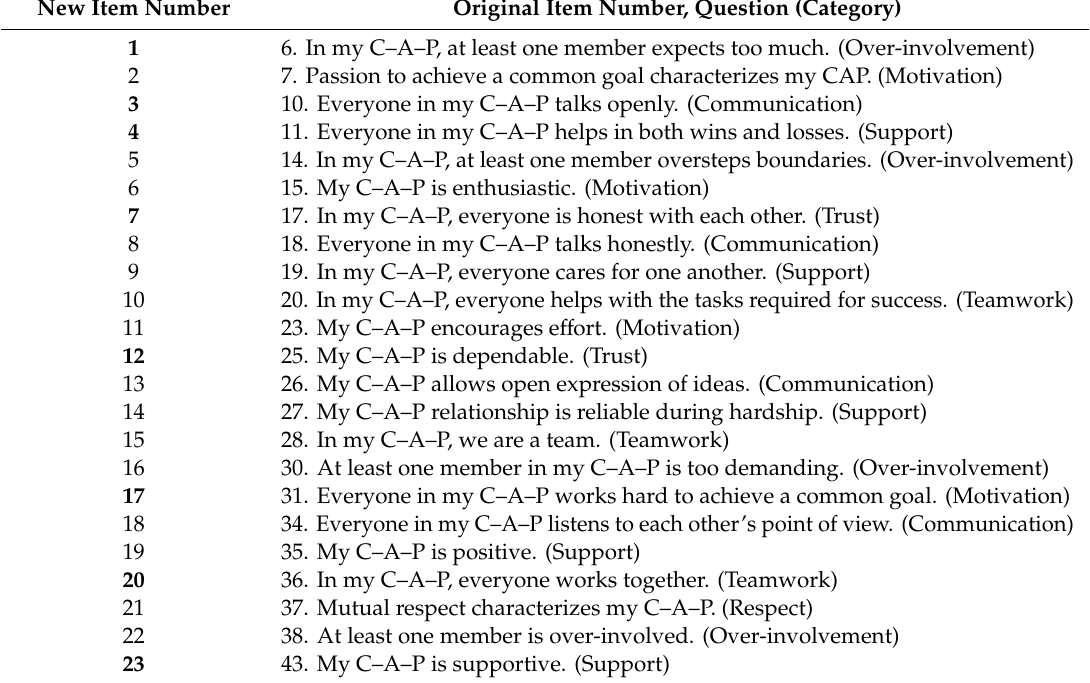
Table 2. The 23-item coach–athlete–parent (C–A–P) with initial conceptualized dimension and item